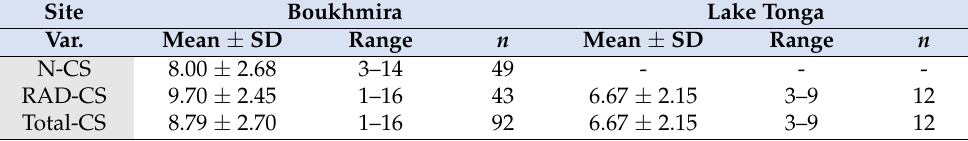
Figure 2. Distribution of clutch sizes in the studied populations, based on radiography and nesting data. Table 2. Clutch size descriptive statistics of the studied populations. Var: variable; SD: standard deviation, n : sample size, N-CS: clutch size sampled in nests, RAD-CS: clutch size detected in females by radiography, Total-CS: pooled clutch size obtained by combination of both nest counts and x-rayed